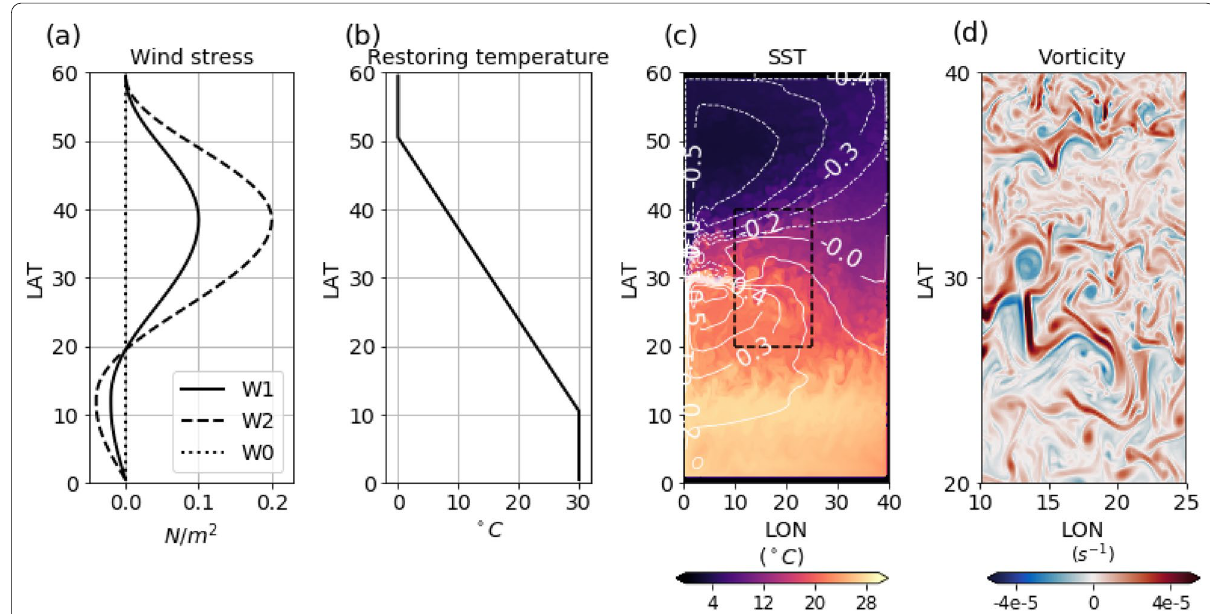
Fig. 1 Model forcing and selected results. a Wind stress, b restoring temperature profile, c instantaneous sea surface temperature (colors) and mean sea surface height (SSH, contours) from the experiment G2B1W1, and d instantaneous relative vorticity in the black‑lined box in c